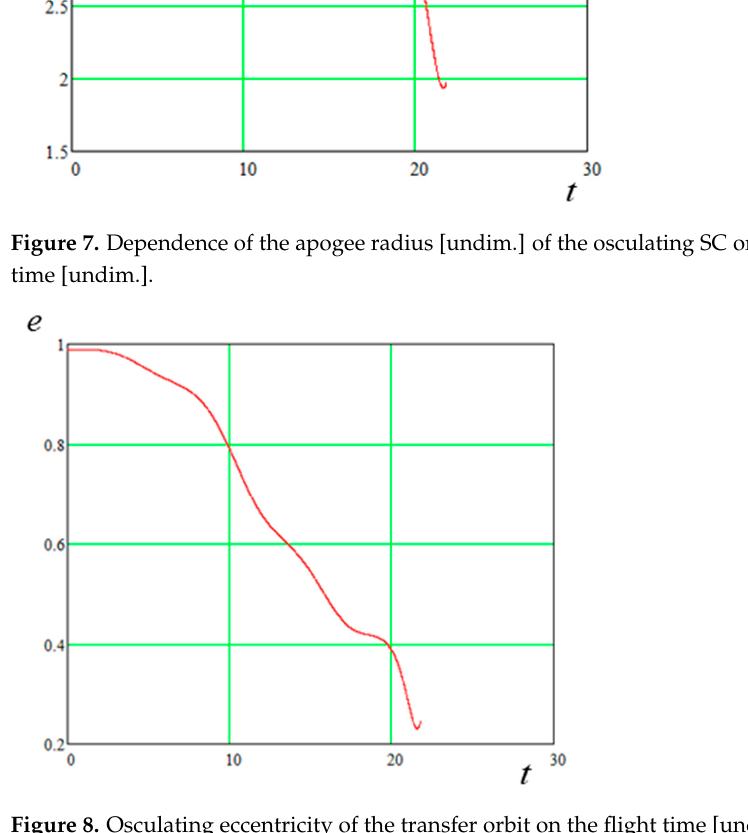
Figure 8. Osculating eccentricity of the transfer orbit on the flight time [undim.].